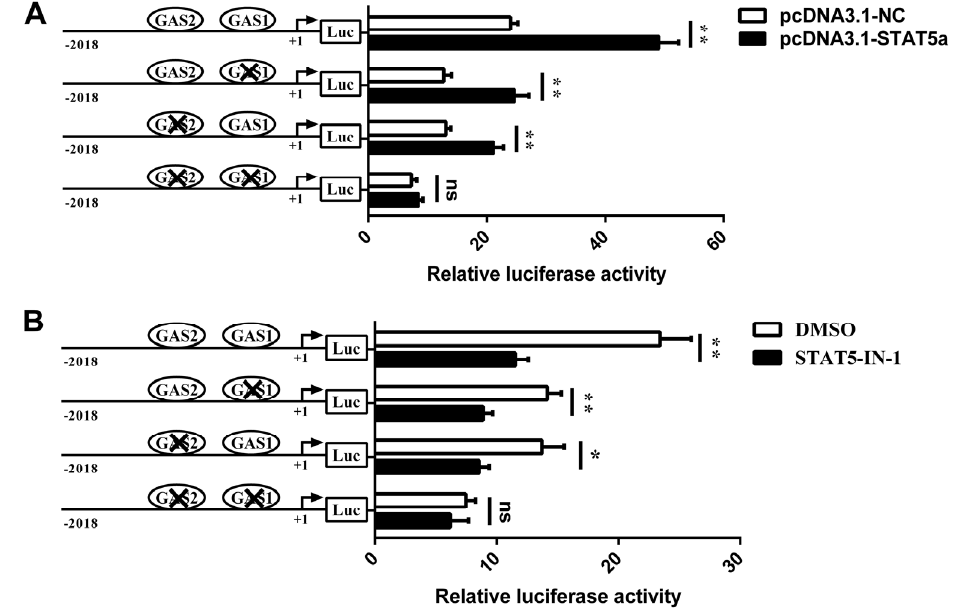
Figure 5. STAT5 regulates the CSN1S1 promoter activity by directly binding to the GAS sites in the CSN1S1 promoter region. ( A ) Effects of STAT5a overexpression on site-mutations of CSN1S1 promoter activity. GMEC were transfected with the wild-type pGL3-CSN1S1 (or GAS site-mutated constructs) followed by pcDNA3.1-STAT5a (or pcDNA3.1-NC) transfection, respectively. At 48 h treatment, cells were measured for luciferase activity. ( B ) Effects of STAT5 inhibition on site-mutations of CSN1S1 promoter activity. GMEC were treated with STAT5-IN-1 (200 µ M, or DMSO) before wild- type pGL3-CSN1S1 (or GAS site-mutated constructs) transfection, respectively. At 48 h treatment, cells were measured for luciferase activity. Data are shown as means ± SEM for 3 biological replicates. * p < 0.05, ** p < 0.01. ns, no